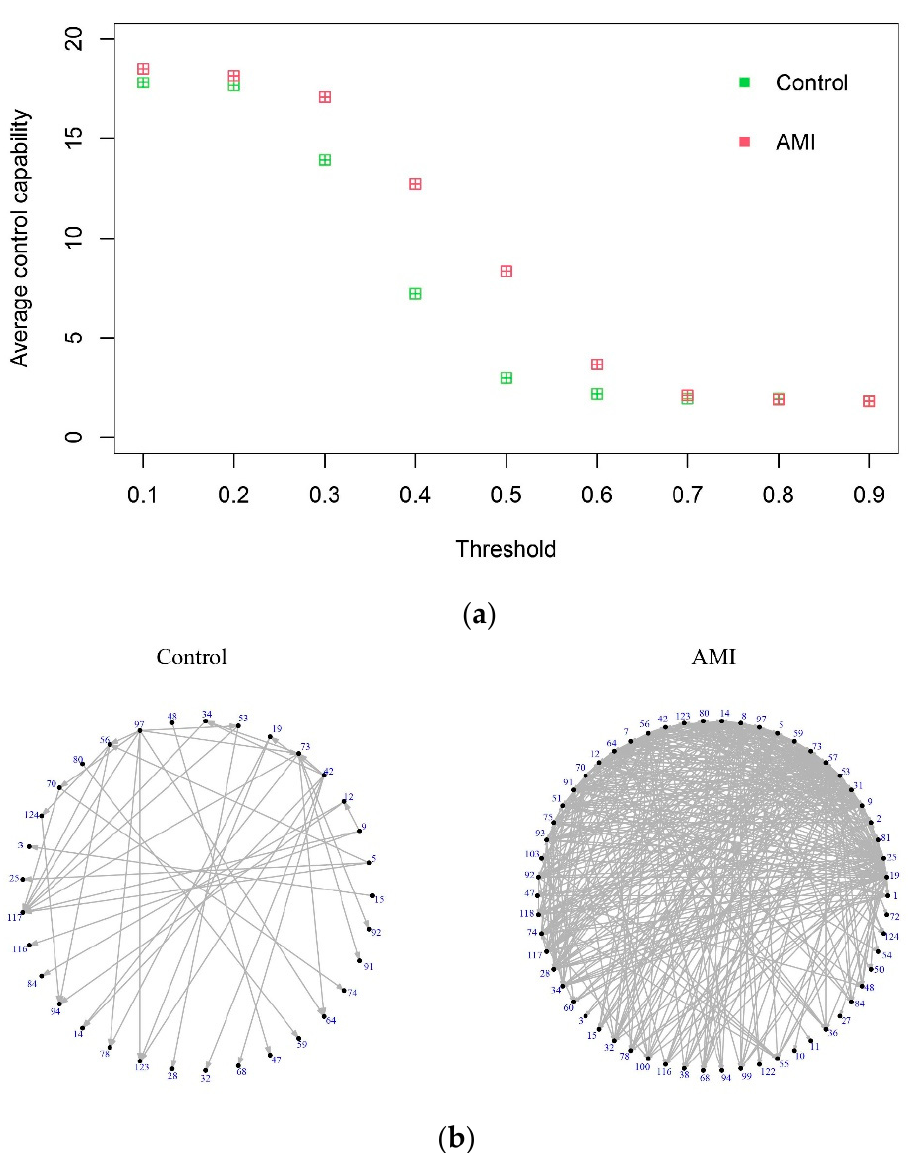
Figure 2. ( a ) Network assessment. Networks in the control and AMI groups are separable according to the average control capability of DEGs; ( b ) logic networks are presented under a threshold of 0.6. The logic networks of DEGs in the AMI group are more complex, compared to that in the control group. Genes represented by node numbers (Table S1).